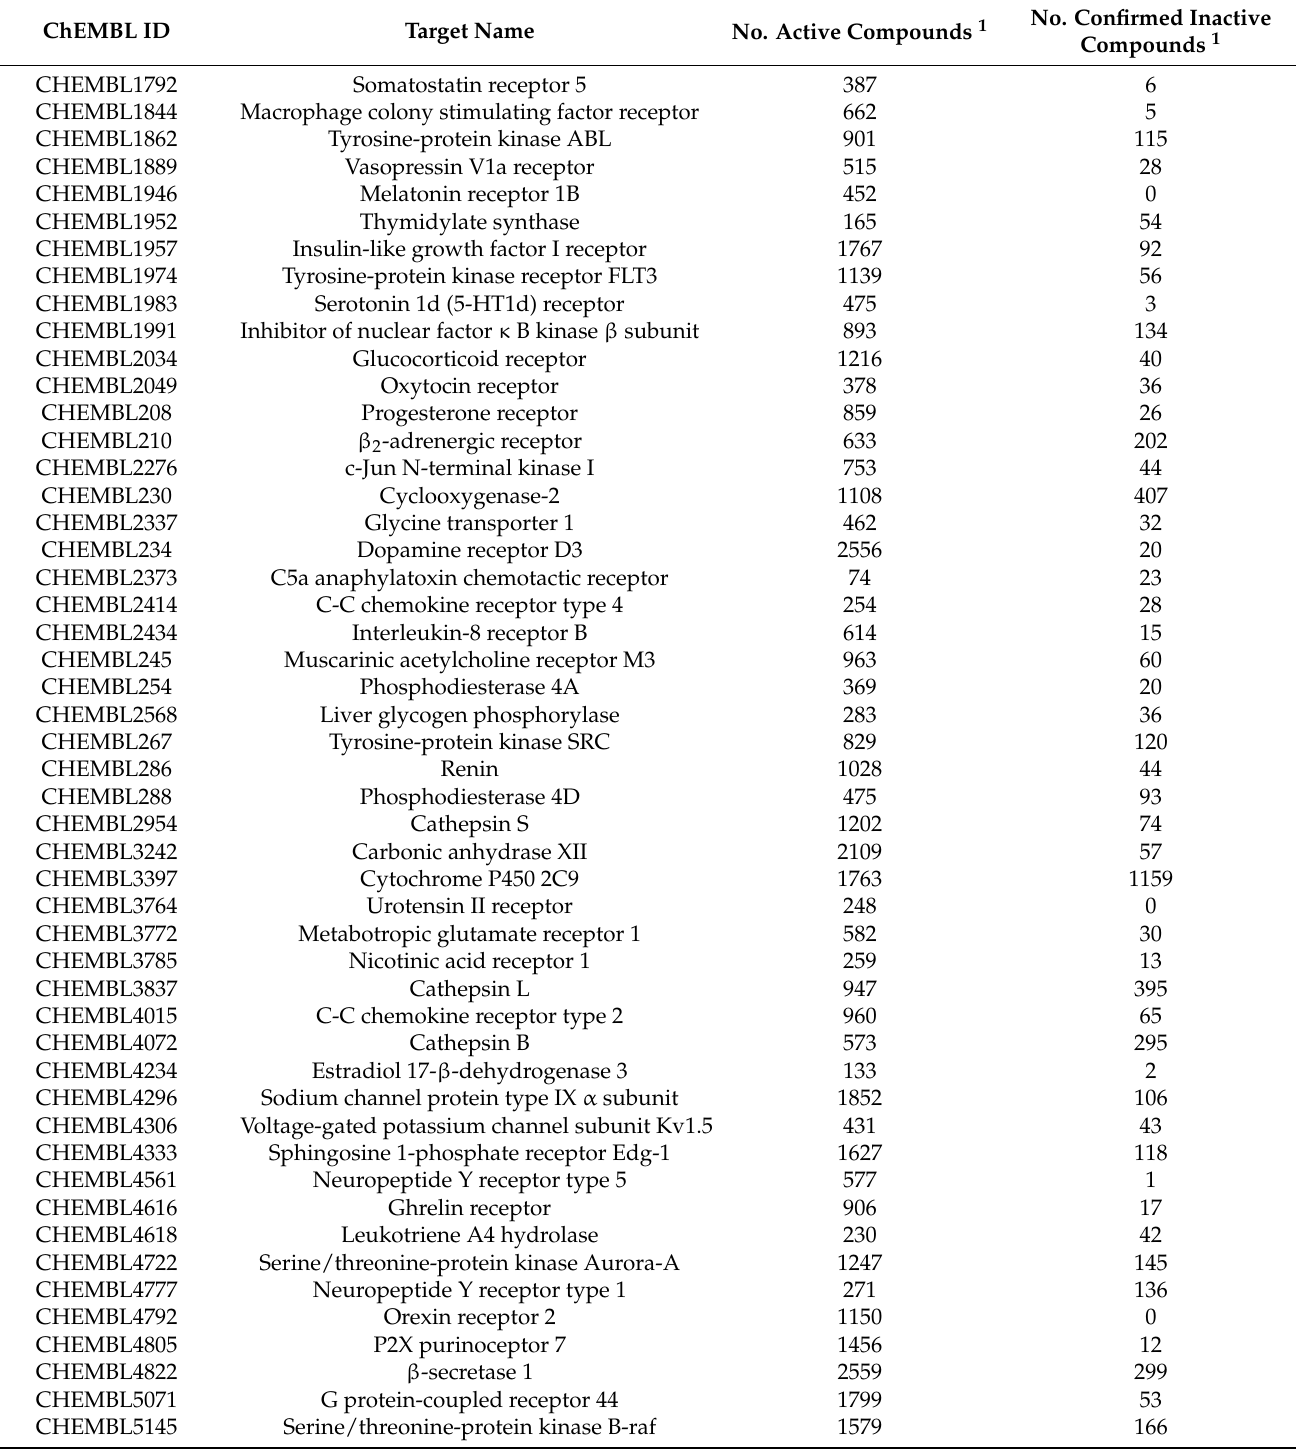
Table 1. Composition of the Prepared Data Set for Virtual